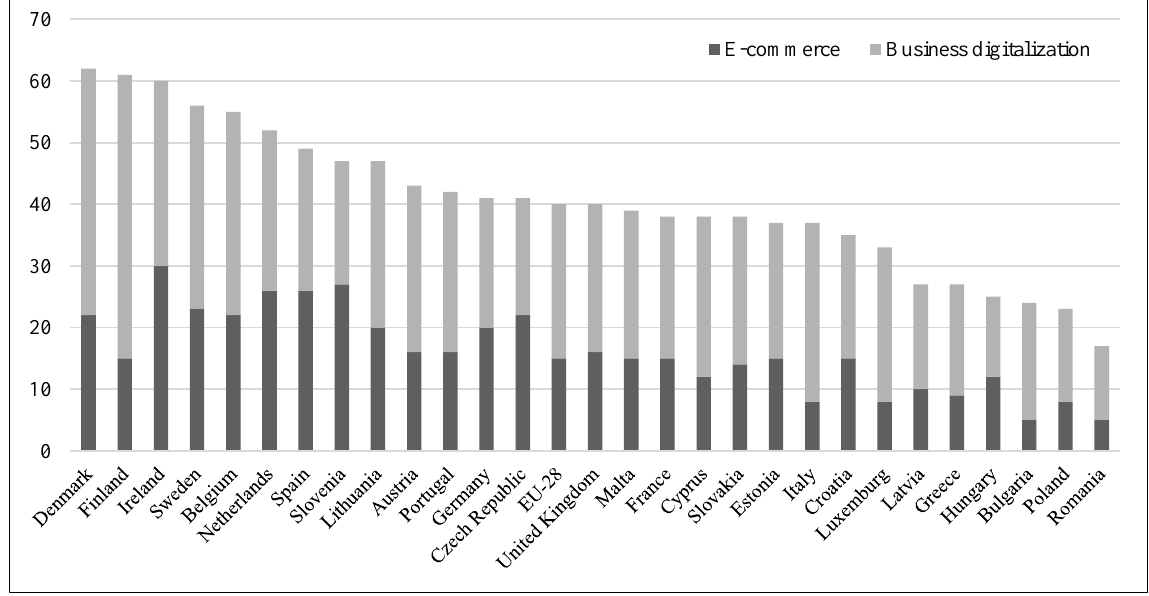
Figure 4. E-commerce and business digitalization development in the European Union Member States, DESI